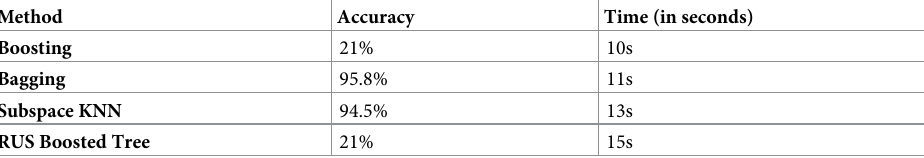
Table 3. Percentage error of alternative Ensemble algorithms.